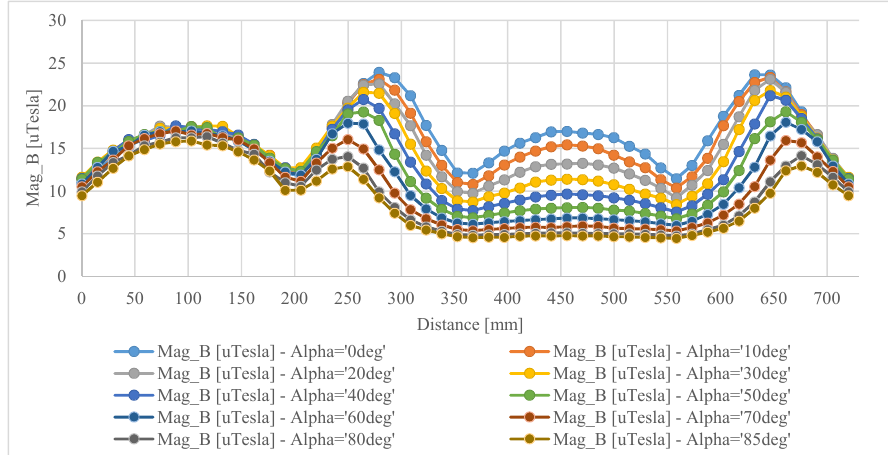
Figure 11. Double-layer winding model DL (24, 16) at different rotation angles of Rx coil.